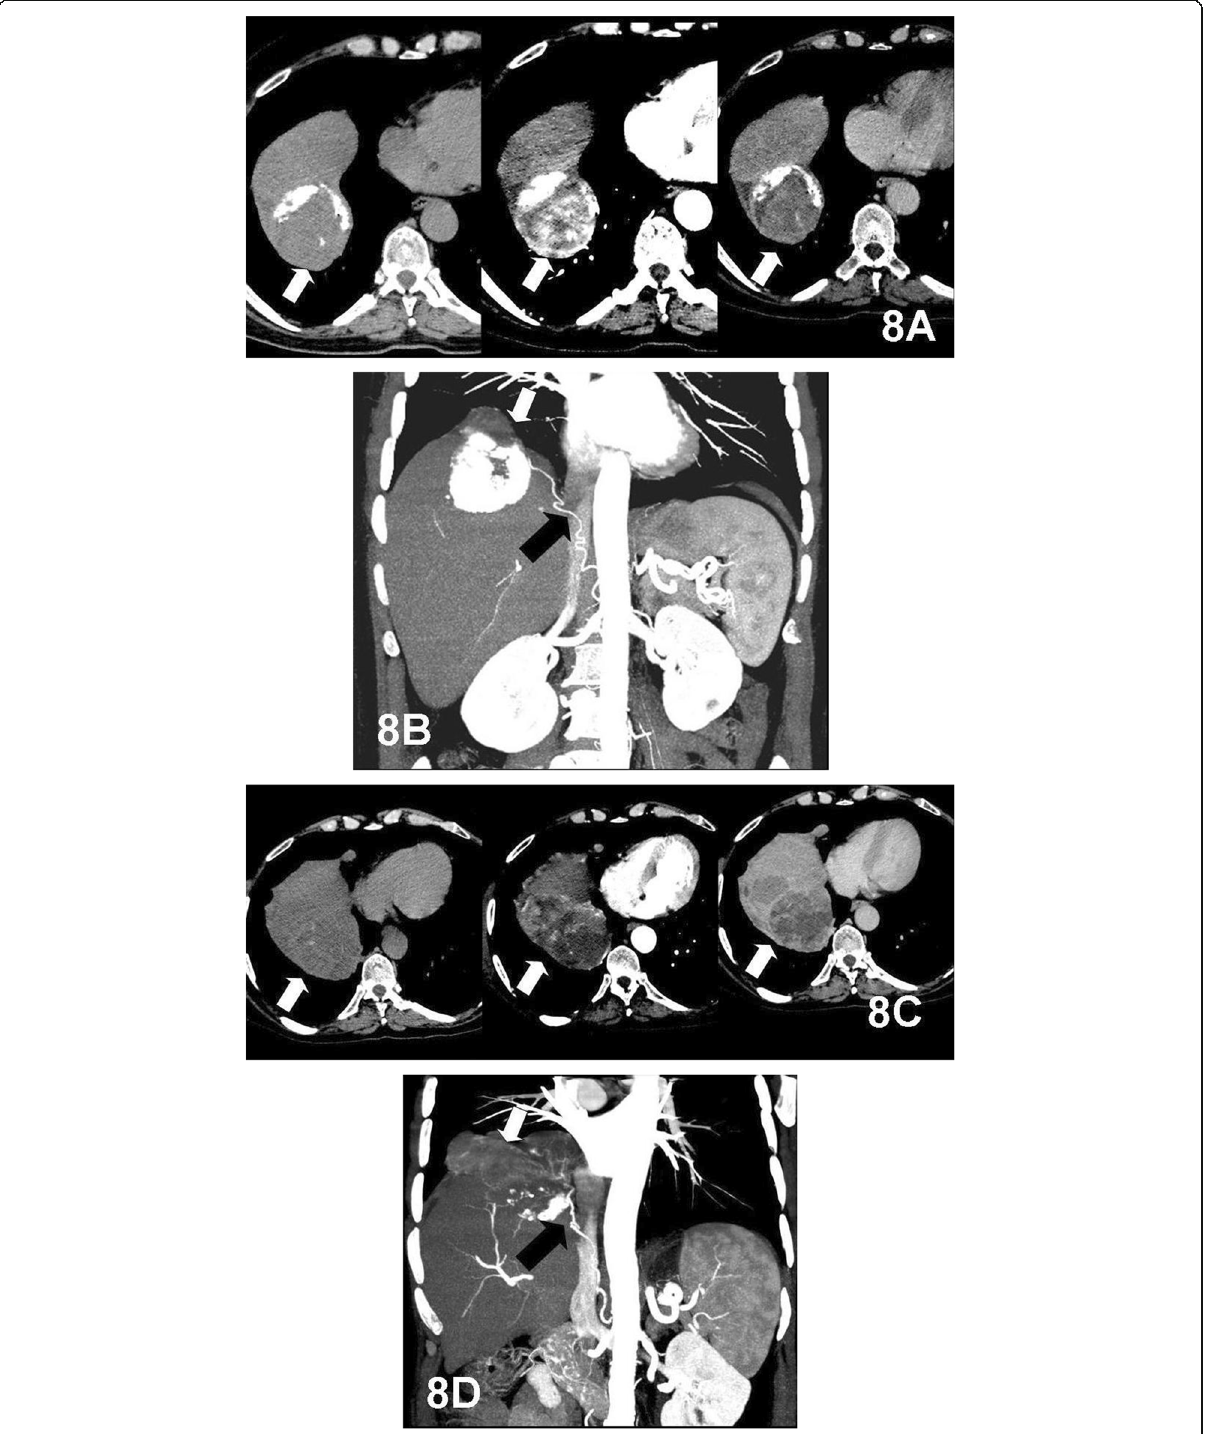
Fig. 8 Follow-up multi-phase CT liver after TACE showing a lipiodol retention with residual/recurrent activity (white arrows) of the managed lesion at the hepatic dome with partial exophytic component. b Coronal MIP showing the arterial supply of the active portion (white arrow) obtained by the right inferior phrenic artery (black arrow). c Follow-up CT, 3 months later showing progression of the active portion (white arrows), due to failure to identify the extra-hepatic collateral arterial supply before TACE. d Coronal MIP of the same study confirms the extrahepatic arterial supply of the progressive active portion of the lesion (white arrow) by RIPA (black